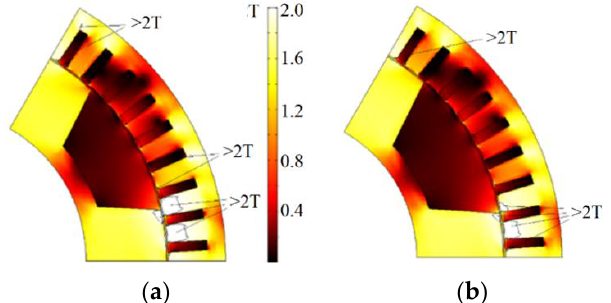
Figure 4. The motor cross-section and the magnitude plot of flux density; black outlines mark the extreme saturation level (>2 T): ( a ) before optimization; ( b ) after optimization; it can be observed that after optimization, the area of regions with flux density >2 T noticeably decreased. Table 6. Varied design parameters of the traction SHM after the